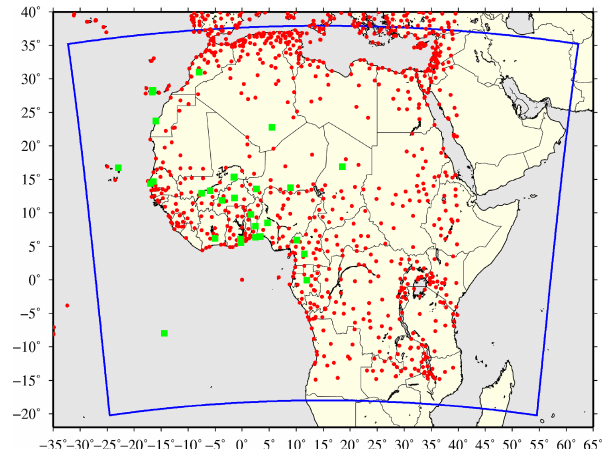
Figure 1. Map of the studied domain. The blue frame represents the modelled domain. The red dots correspond to the Met Office MIDAS meteorological surface stations. The green dots correspond to the AERONET